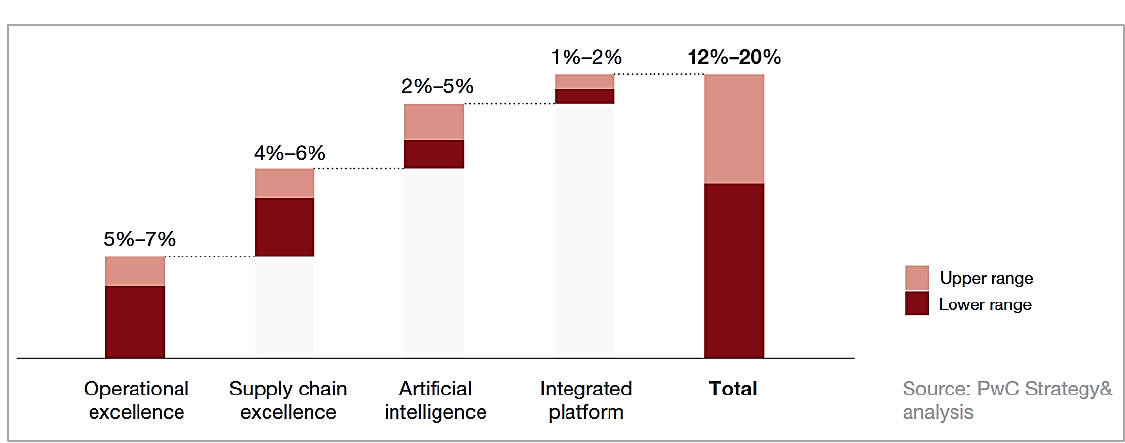
Figure 2. Efficiency increase from digitalization